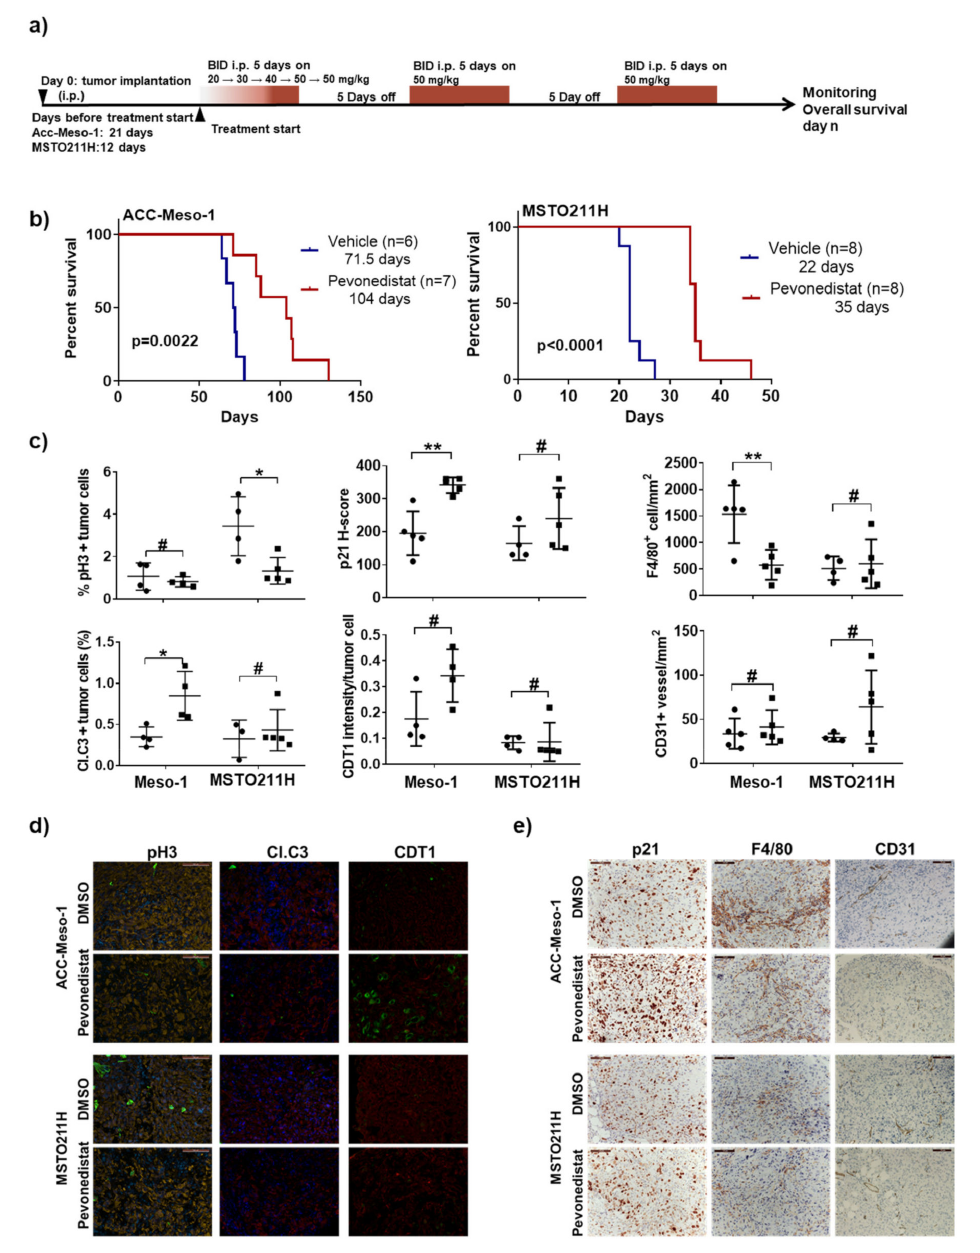
Figure 5. E ffi cacy and mechanisms of pevonedistat in an in vivo model. ( a ) Scheme depicting the schedule for tumor implantation and pevonedistat treatment cycles for the mouse model. ( b ) Kaplan-Meier plots showing significant di ff erences in the overall survival (days) between the vehicle and pevonedistat-treated mice bearing an ACC-Meso-1 tumor (left) and MSTO211H tumor (right). ( c ) Comparison of tumor growth (pH3 + ), apoptosis (cleaved caspase 3, Cl.C3), CDT1 intensity, p21 H-score, mouse macrophage recruitment (F4 / 80 + cells per tumor area) and mouse vessel formation (CD31 + group of cells with visible lumen per tumor area) between vehicle-treated (filled circles) and pevonedistat-treated mice (filled squares). # not significant; * p < 0.05, ** p < 0.001, ( d ) Representative images of immunofluorescent staining for the indicated proteins with a green signal. They were co-stained with DAPI (blue) and pan-cytokeratin (yellow or red). The DAPI signal was omitted from CDT1 staining for a better visualization of the CDT1 signal. ( e ) Immunohistochemical staining of the indicated markers and counterstained with hematoxylin (blue). Scale bars represent 100 µ